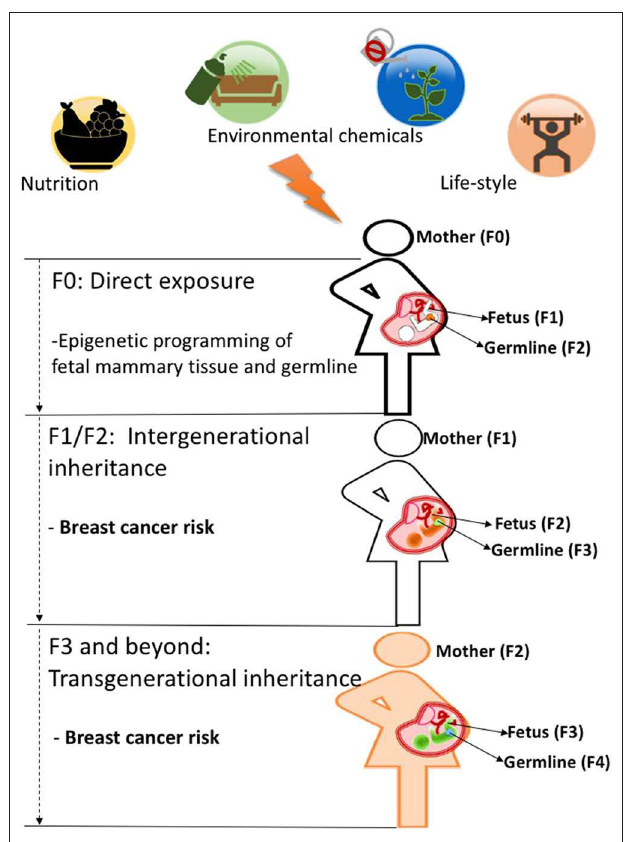
FIGURE 1 | When a mother (F0, black outline) is exposed to an environmental insult such as an unhealthy diet during pregnancy, her offspring’s mammary tissues (F1 generation, fetus with black outline) and its already developing germ cells (orange)-which will give rise to the F2 generation-will be directly programmed and may cause intergenerational effects on F2 generation’s breast cancer predisposition (fetus with orange color). Those environmental effects on breast cancer risk can be carried to subsequent generations (F3 generation and beyond, fetus wit green color) and represent true transgenerational epigenetic inheritance as they are transmitted through the F2 germline (green) which was not directly exposed to the initial environmental insult in the F0 generation. While evidence in humans is still lacking, animal studies support the idea that transgenerational epigenetic inheritance of breast cancer predisposition occurs (4, 48,